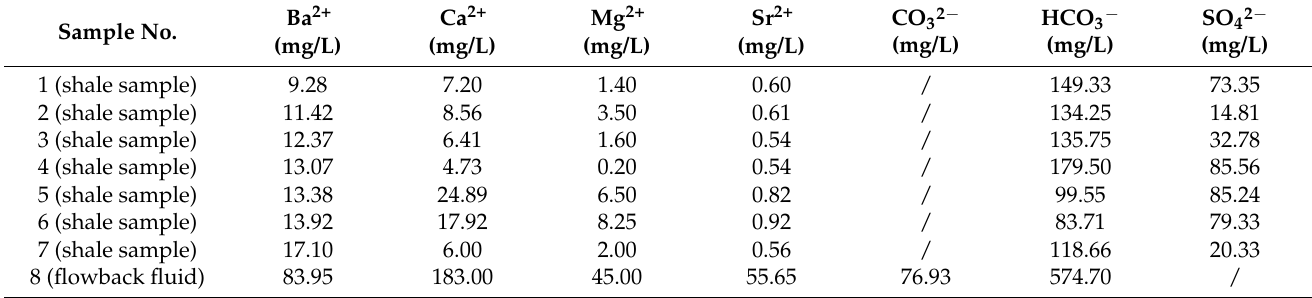
Table 4. The ionic component of immersion fluid after shale particles soaked in distilled water. Sample